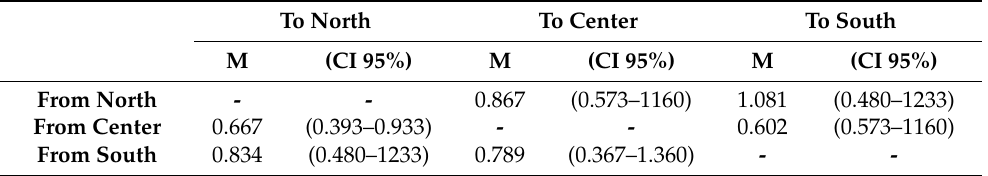
Table 3. Asymmetric estimations of gene flow between pairs of populations as calculated in Migrate. M: Mean value of the estimator of migrants per generation; CI 95%: 95% confidence intervals of estimates.